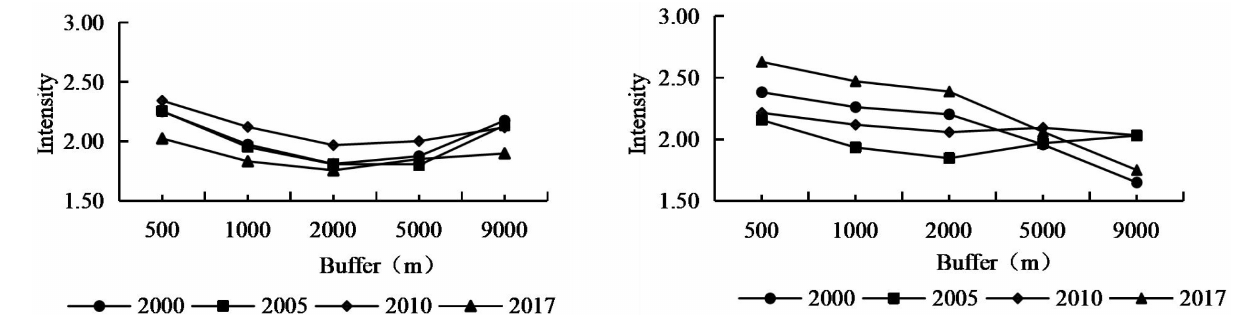
Figure 6. Land-use intensity of different buffers in the study area from 2000 to 2017.